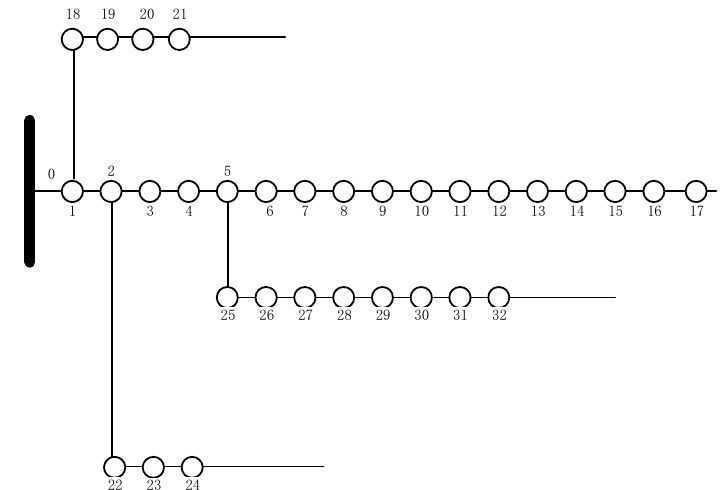
Figure 8. Institute of Electrical and Electronics Engineers (IEEE)33-bus distribution network system.